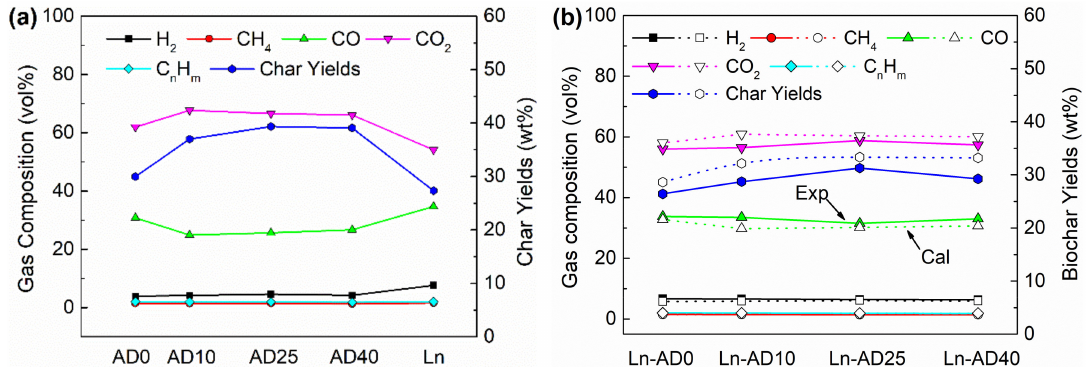
Figure 6. The gas compositions and biochar yields of ( a ) gasification of single samples and ( b ) co-gasification of lignite and